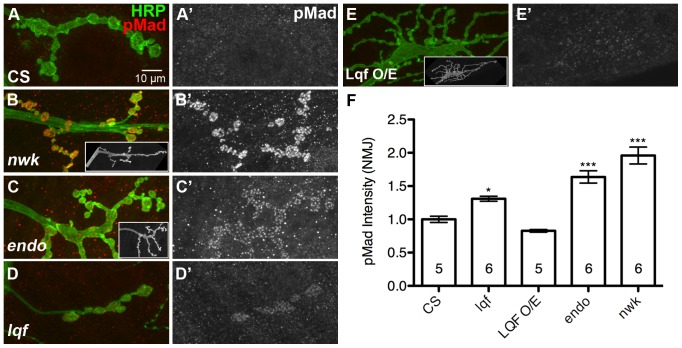
Lqf and other endocytotic proteins negatively regulate pMad at the larval NMJ.(A–E') Representative images of pMad (red) in Drosophila 3rd instar larval NMJs. Neuronal membranes are marked by HRP (green). (A'–E') show pMad signal alone. In (B and C) apparent synaptic overgrowth corresponds to increases in synaptic pMad levels for nwk and endo mutants compared to that in the wild type control (CS, A). (D and F') Synaptic levels of pMad are also significantly elevated in lqf mutants, but there is no corresponding NMJ overgrowth. Neuronal overexpression of Lqf (ElavC155-Gal4/+; UAS-Lqf/+) causes both a reduction in synaptic pMad levels, and dramatic overgrowth (E and F). (F) Quantification of pMad signal in A–E. Error bars represent SEM, three animals per genotype were quantified, n values represent the number of NMJs for each genotype. *P<0.05, **P<0.01, ***P<0.001. One-way ANOVA with Tukey's Multiple Comparison Post test. Control (CS), nwk (nwk1/nwk1), endo (endoA/endoΔ4), lqf (lqfARI/lqfFDD9), LqfO/E (ElavC155-Gal4/+; UAS-Lqf/+).